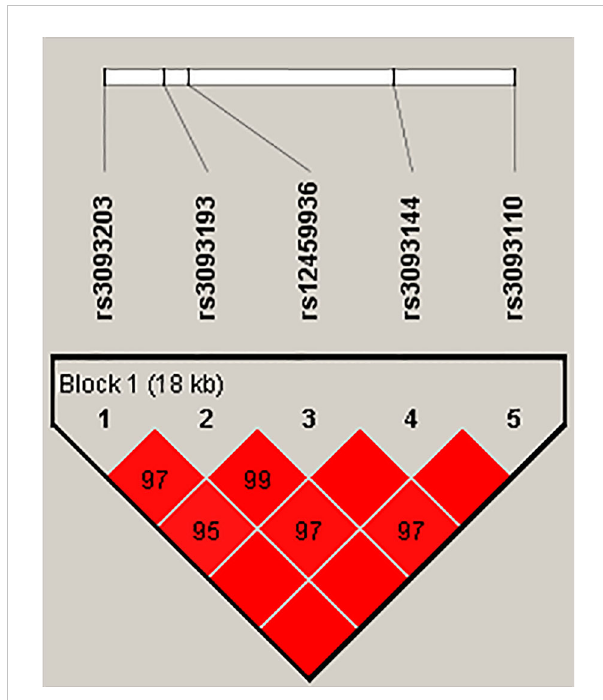
FIGURE 1 Haplotype block map for SNPs in the CYP4F2 gene. The numbers inside the diamonds indicate the D ′ value × 100 for pairwise analyses.